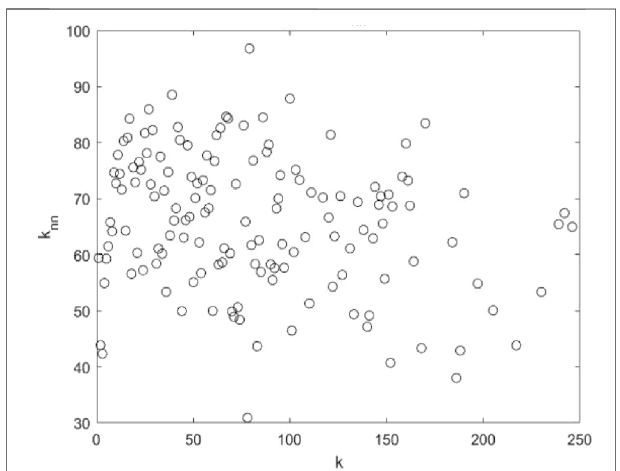
FIGURE 6 | Relationship between the average betweenness of the adjacent nodes ( ( g nn ( k )) ) and the betweenness (k) in the global aviation network.